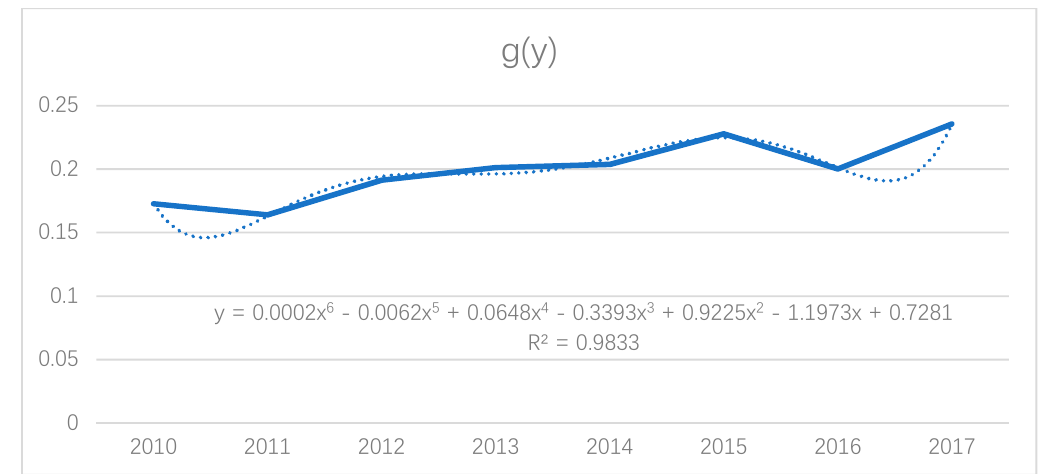
Figure 6 ． The comprehensive evaluation values of ecological environment benefits of land use.